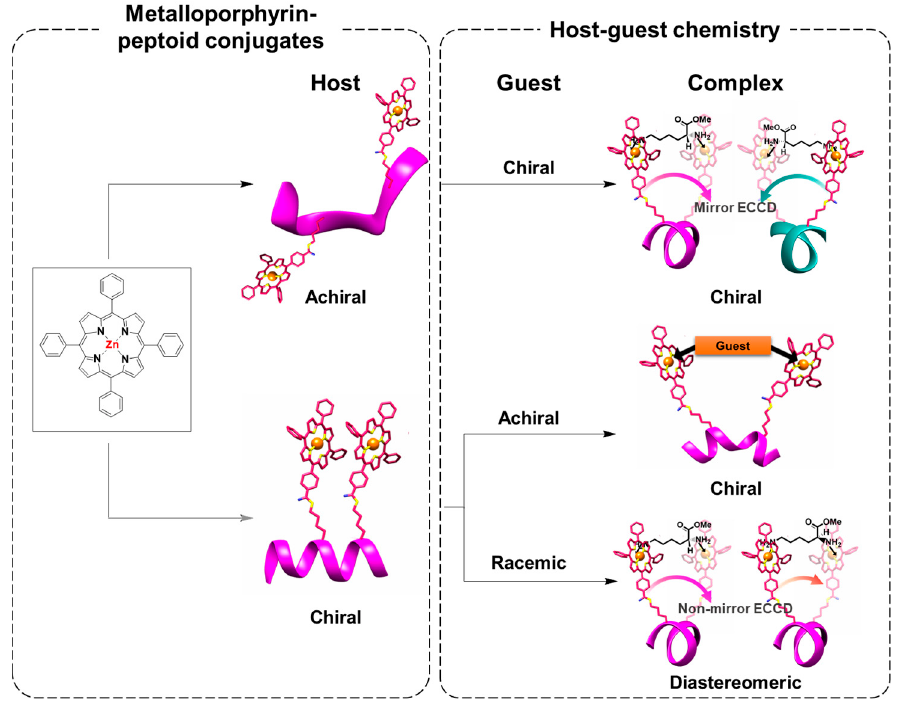
Figure 1. Schematic illustration of host–guest complexation between metalloporphyrin-peptoid conjugate (MPPC) and guest. Specific interactions between achiral host-chiral guest, chiral host-achiral guest, and chiral host-chiral guest are investigated in this study.